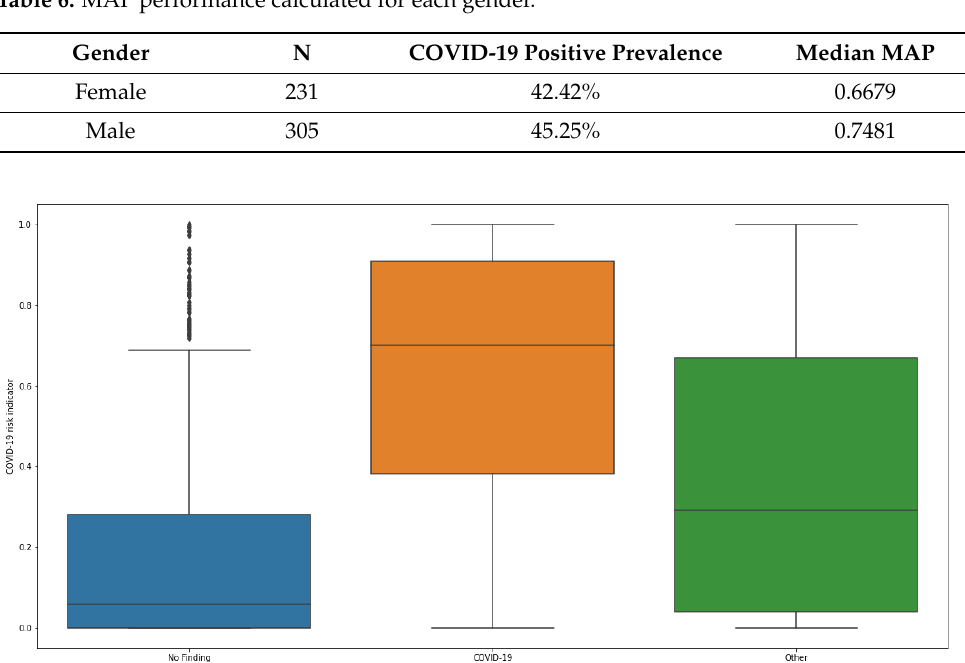
Figure 9. Distribution of the predicted COVID-19 risk indicator for cases belonging to the three clas- ses, divided by gender. Blue boxes are referring to female, while orange ones are to male. We computed the Spearman correlation coefficient [Rs] between patient age and COVID-19 risk indicator computed by the proposed algorithm for patients positive for COVID-19, on both the whole dataset and divided by gender group. The results are sum- marized in Table 7. For the whole dataset, there was almost no correlation with age, Rs = −0.004, p -value = 0.884; in [35], a low positive correlation was obtained, but it was not statistically significant. Grouped by gender, the correlation result was low and positive in both cases, but not significant, Rs = 0.167 p -value < 5.52 × 10 −10 for the female group, and Rs = 0.065 p -value < 5.13 × 10 −4 for the male one, confirming the results in [35]. Table 7. COVID-19 risk indicator grouped by age group and gender for COVID-19 positive patients. In bold, significant p -values. Age Group